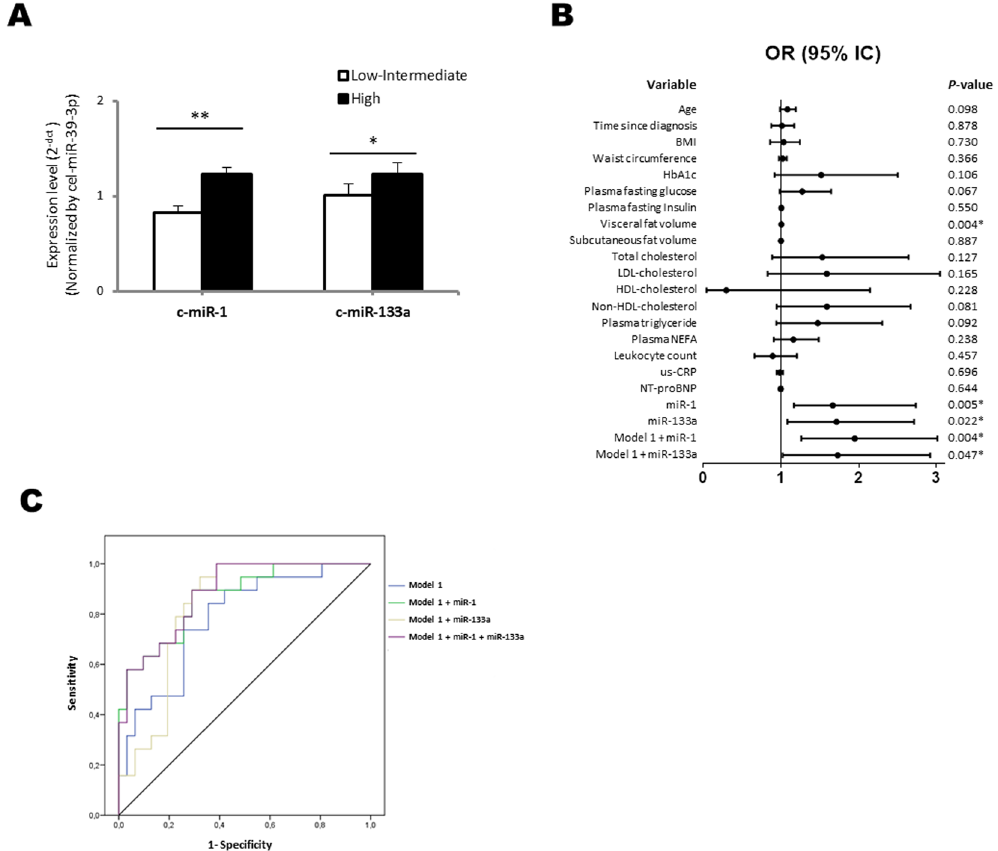
Figure 1. ( A ) Quantification by RT-qPCR of serum miR-1 and miR-133a levels in patients with uncomplicated type 2 diabetes in tertiles 1 and 2 (low-intermediate levels; N = 48) or 3 (high levels; N = 24) of myocardial steatosis. Relative quantification was performed using cel-miR-39-3p for normalization. Differences between groups were analysed using a Student’s t-test for independent samples. Data represent the mean + SD. * P < 0.050; ** P < 0.010. ( B ) Association between myocardial steatosis and clinical parameters or serum cardiomyocyte-enriched miRNAs in patients with uncomplicated type 2 diabetes. Univariate and multivariate logistic regression models were used to explore the association between serum cardiomyocyte-enriched miRNA and myocardial steatosis as outcome. OR: Odds Ratio, CI: Confidence Interval. ( C ) ROC curves for the logistic regression models of myocardial steatosis. Model 1: age, plasma fasting glucose, visceral adipose tissue, plasma TG and